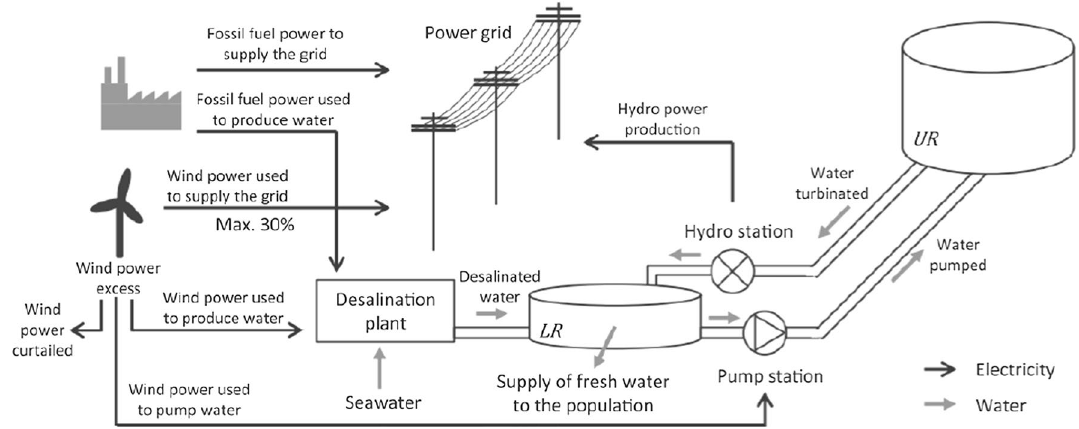
Fig. 33 Combining wind turbine, power grid and desalination plant for producing freshwater (Segurado et al.